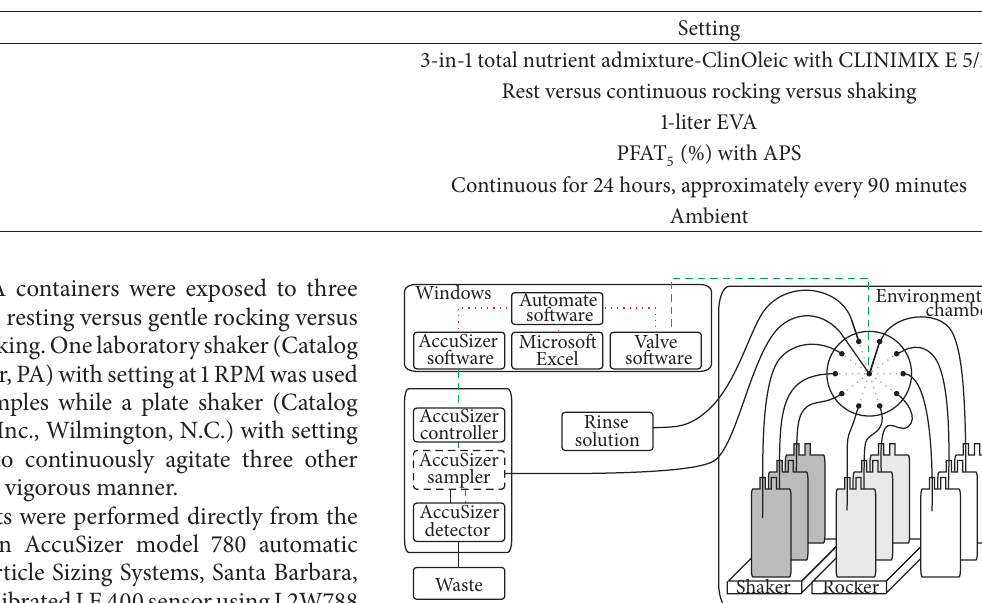
Table 1: Conditions for probing parenteral emulsion dynamics—agitation experiment.